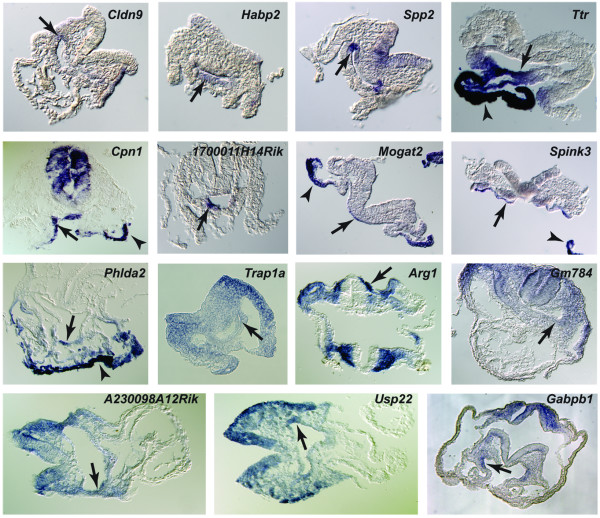
Histological sections through the embryos as indicated by the line in Figure 6, with arrows pointing to the DE staining. Arrowheads indicate staining in visceral endoderm.